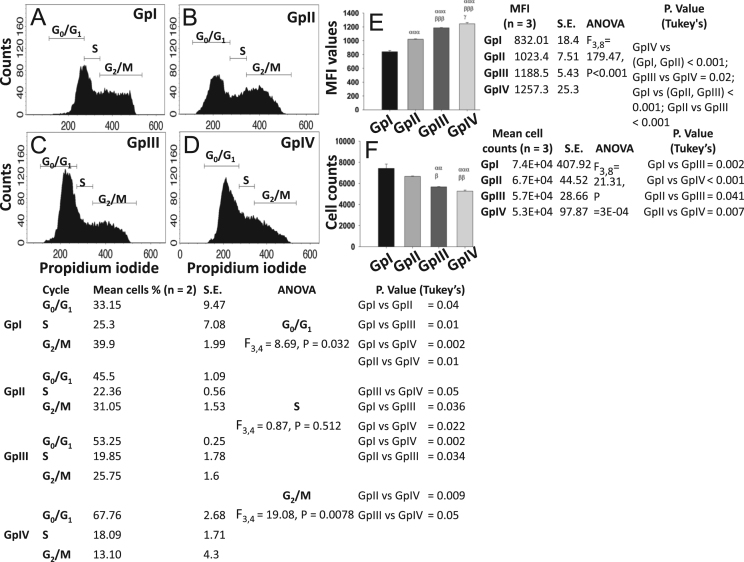
Modulation in cell cycle and proliferation pattern of neuro-2a under varied serum conditions with presence/absence of retinoic acid. Neuro-2a cells were subjected to culture conditions, namely DMEM + 10% FBS (GpI), DMEM + 10% FBS + 20 μM Retinoic acid (GpII), DMEM + O.1% FBS (GpIII), DMEM + 0.1% FBS + 20 μM Retinoic acid (GpIV) for 24 h, processed as per respective protocols and then scanned using FACS Calibur™. Cell cycle data are represented as the histogram (A–D) and CFSE assay data is represented in bar graphs (E, F) showing mean fluorescence intensity values (MFI values) and cell counts (cells/9.6 cm2) respectively. Values are mean ± S.E. P ≤ 0.05 (α, β, γ), P ≤ 0.01 (αα, ββ, γγ), P ≤ 0.001 (ααα, βββ, γγγ) were considered to be statistically significant. α, Compared to GpI; β, Compared to GpII; γ, Compared to GpIII. Additionally, mean data values, S.E., ANOVA statistics and P. Values from Tukey׳s multiple comparisons (post hoc) are represented besides respective graphical representations.